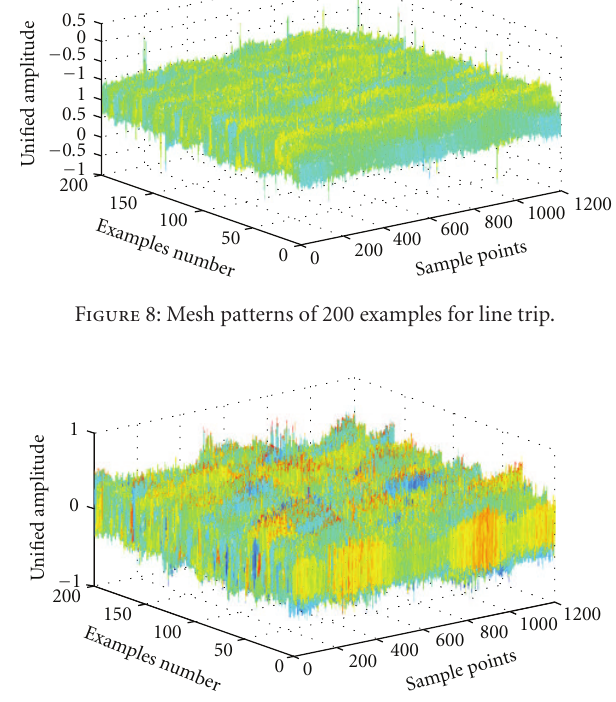
Figure 9: Mesh patterns of 200 examples for frequency oscillation.